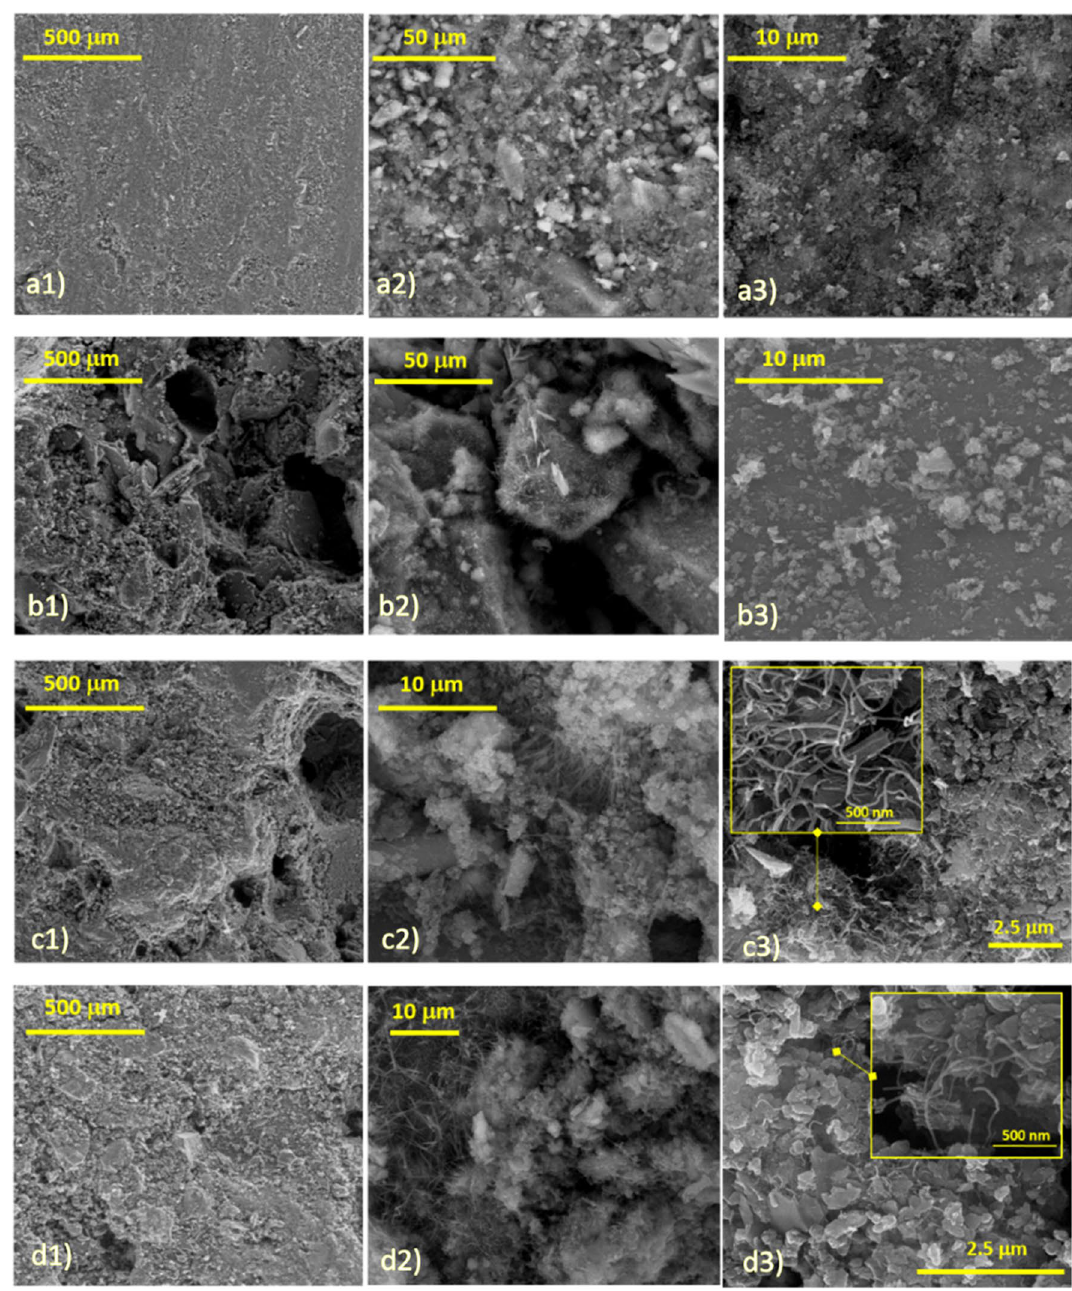
Figure 4. SEM images at different magnifications of ( a ) M 0 , ( b ) M 1 , ( c ) CM 2 , and ( d ) CM 3